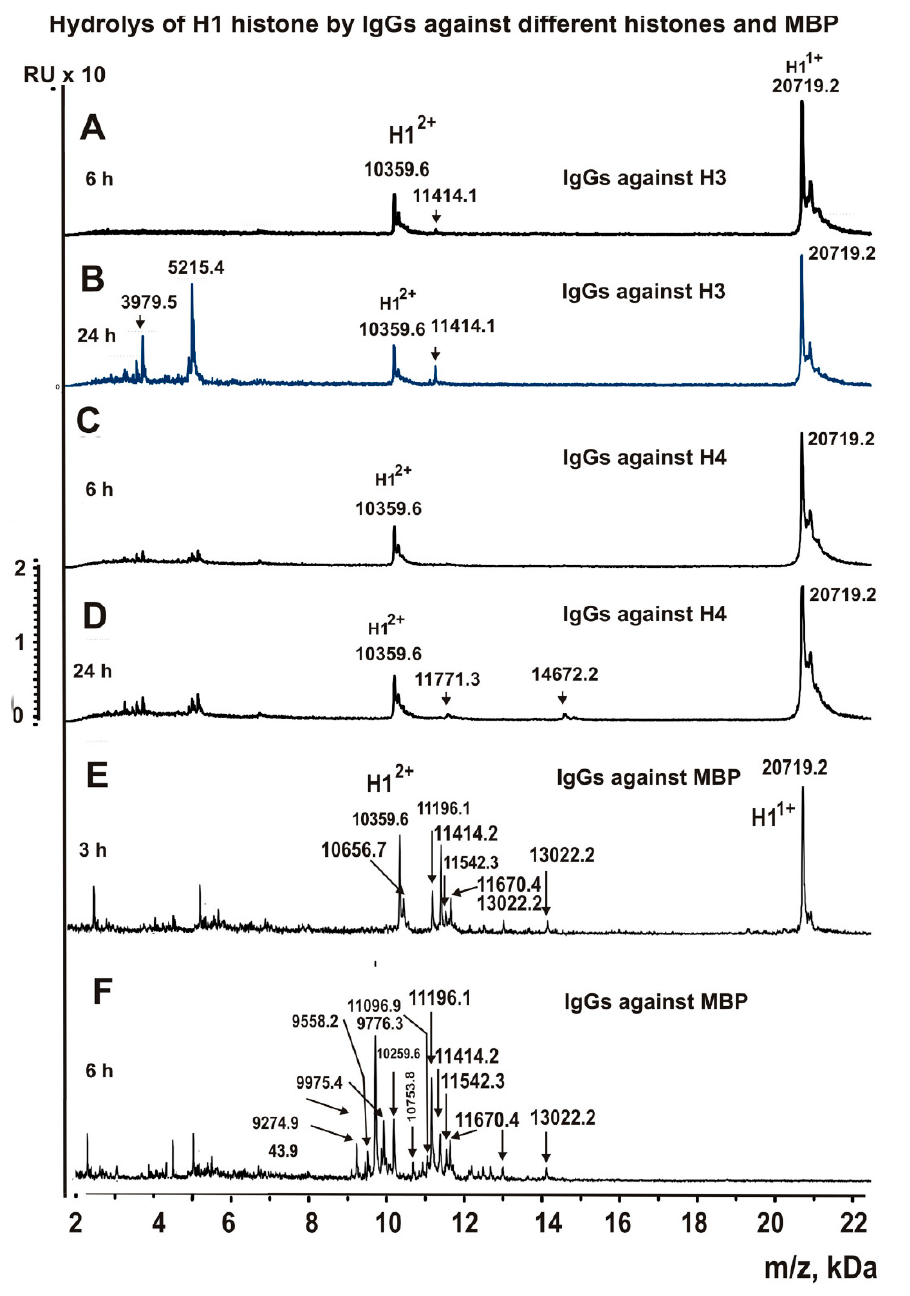
Figure 3. MALDI spectra ( A – G ) corresponding to H1 histone (0.7 mg/mL) hydrolysis over time (6–24 h), in the presence of IgGs (0.04 mg/mL) against H3 ( A , B ), H4 ( C , D ), and MBP ( E , F